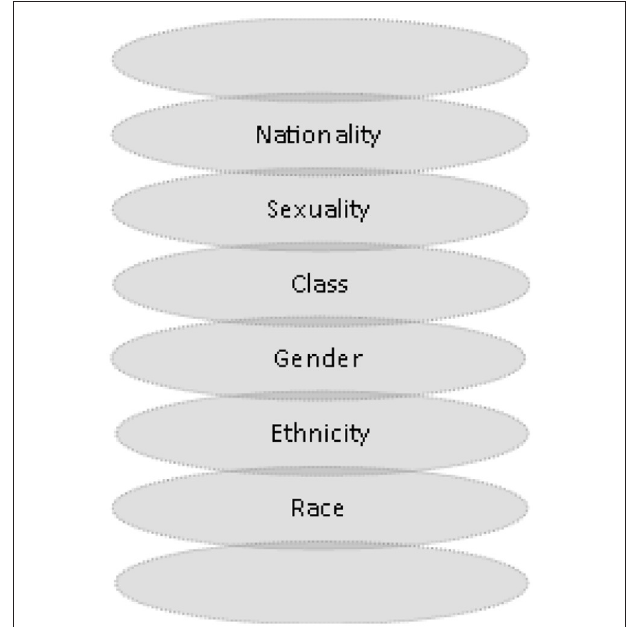
FIGURE 1 | Theories of difference: making a difference with simultaneity ( Holvino, 2005) (http://slideplayer.com/slide/4446160/). Permission received for reprint from Evangelina